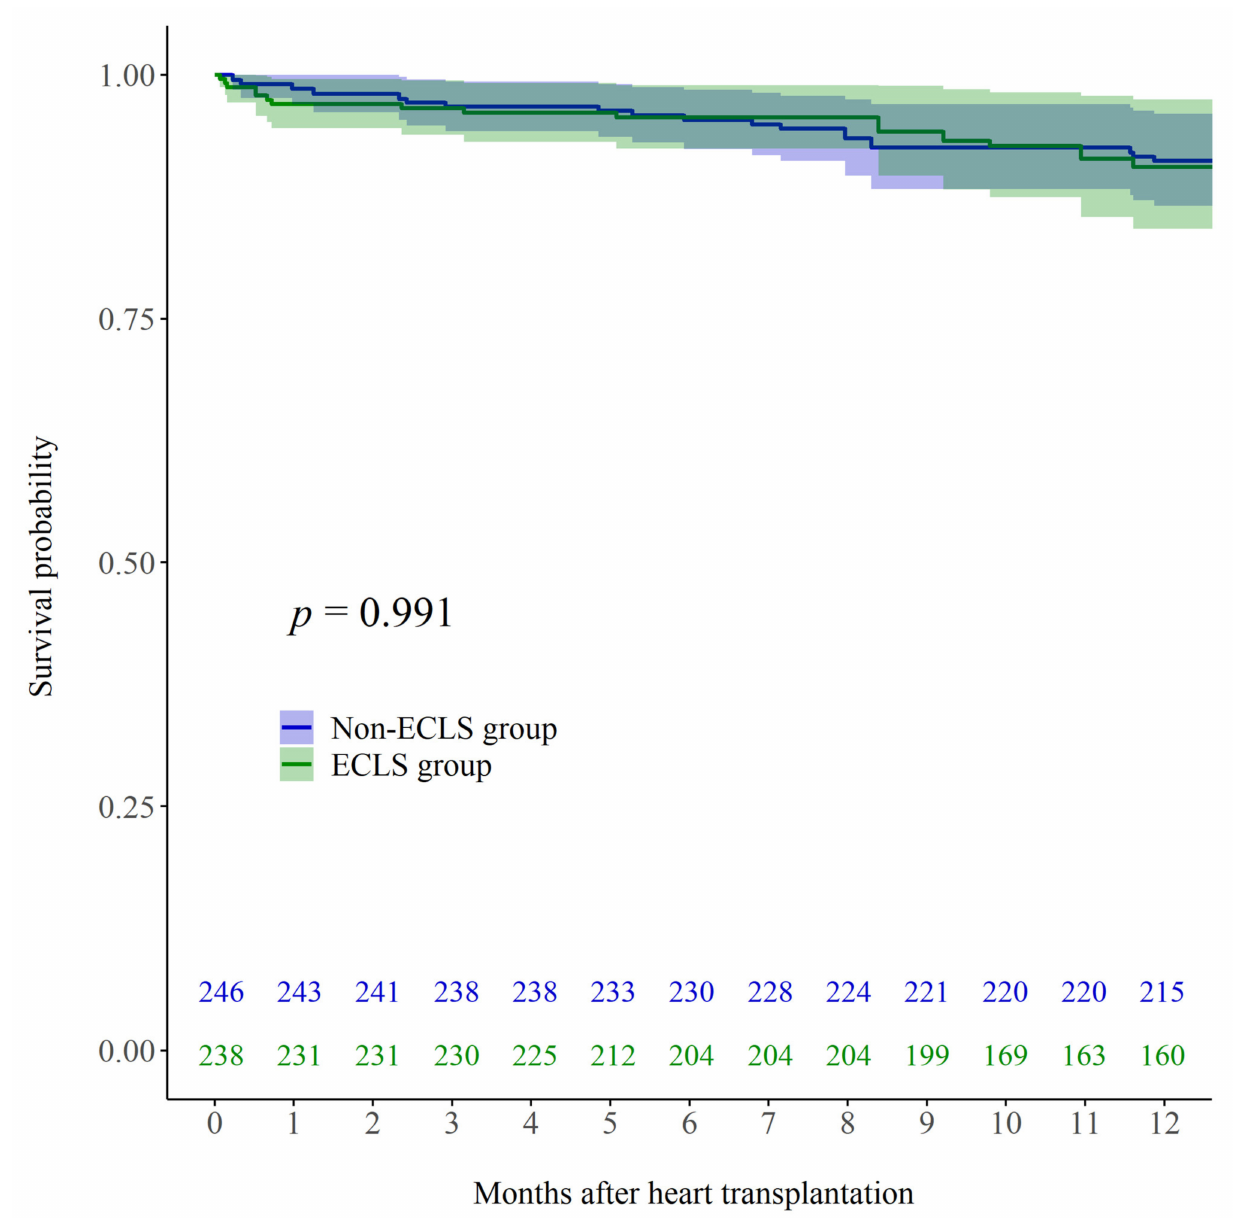
Figure 2. Kaplan–Meier post-HTx survival curves for patients who received ECLS while waiting for HTx (ECLS; green line) and those who did not receive ECLS before HTx (Non-ECLS; blue line) after multivariable adjustment including IPTW. HTx, heart transplantation; ECLS, extracorporeal life support; IPTW, inverse probability of treatment